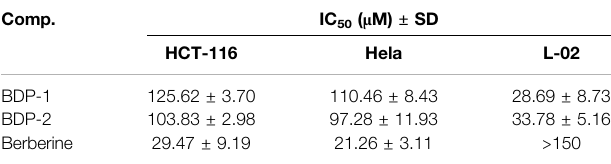
TABLE 2 | Cytotoxicity analysis of BDP-1 and BDP-2 with the drug berberine as reference.